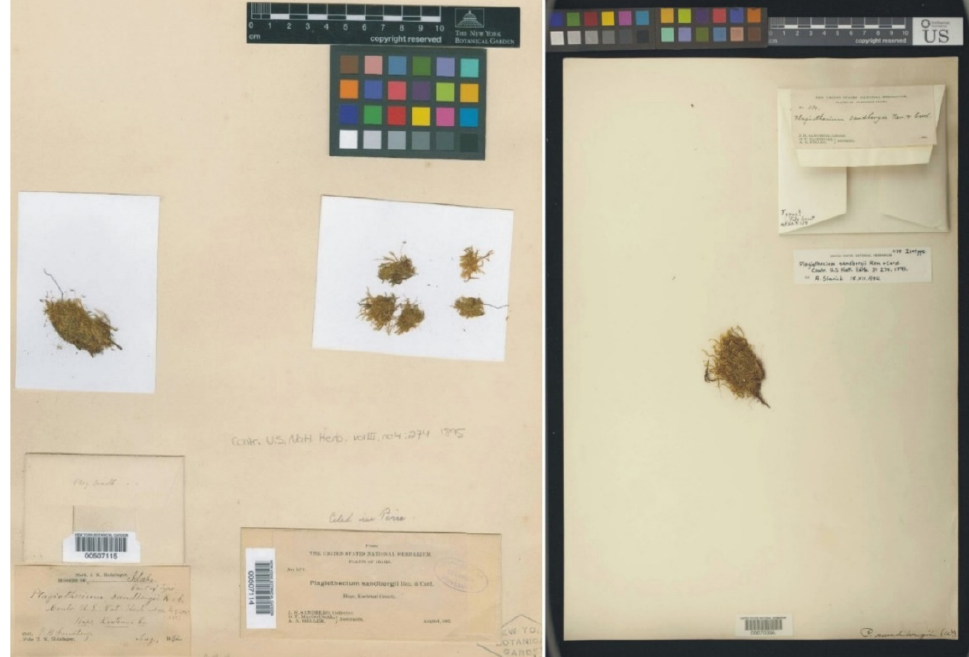
Figure 9. Two other syntypes of P . sandbergii . On the left, a sheet with specimens from the NY herbarium, on the right, a specimen deposited in the US herbarium (from https://bryophyteportal.org (accessed on 15 April 2022)).